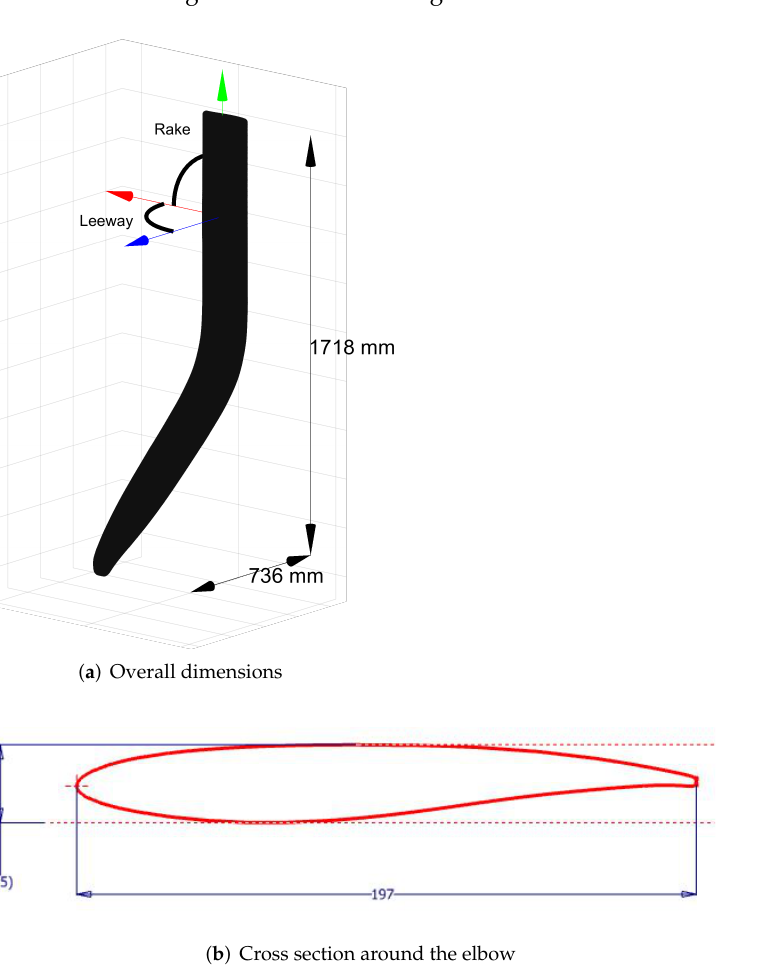
Figure 5. Main dimensions of the hydrofoil. Cross section taken from the elbow of the